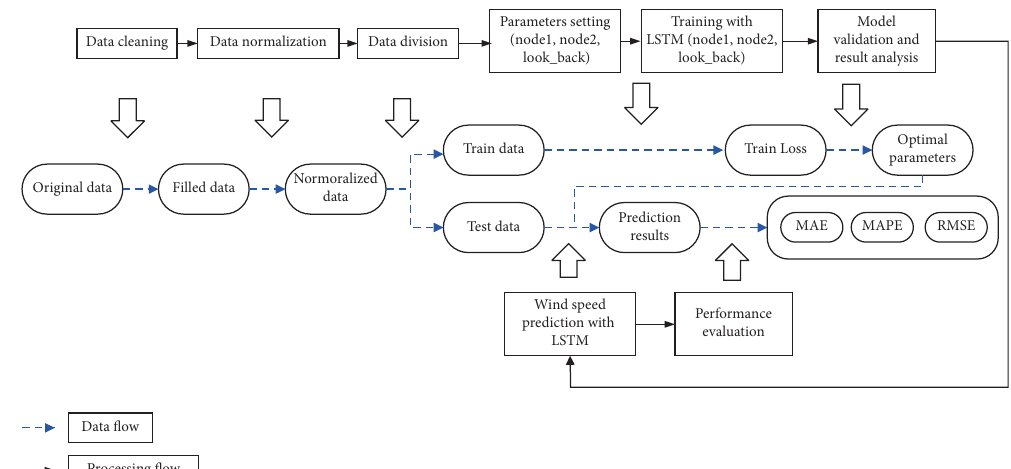
Figure 2: General schematic diagram for LSTM-based wind speed